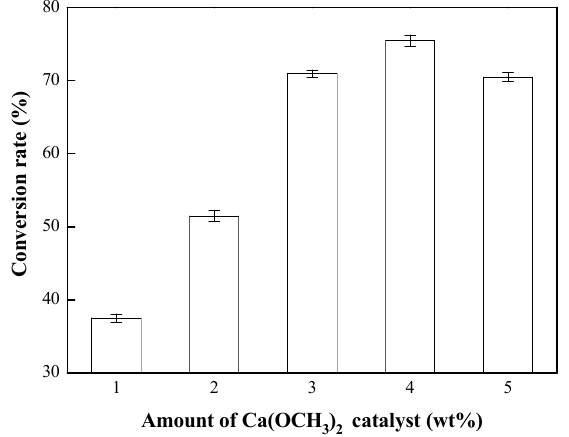
Figure 6. Effect of catalyst amount on the transesterification reaction. Reaction conditions: methanol-to-oil molar ratio: 6:1; rotation speed: 7000 rpm; reaction temperature: 65 °C; reaction time: 60 min; catalyst amount: 1–5 wt %.